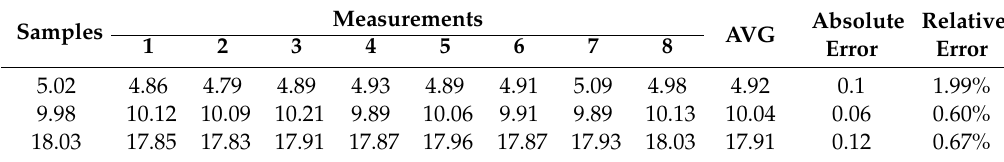
Figure 10. Precision test.